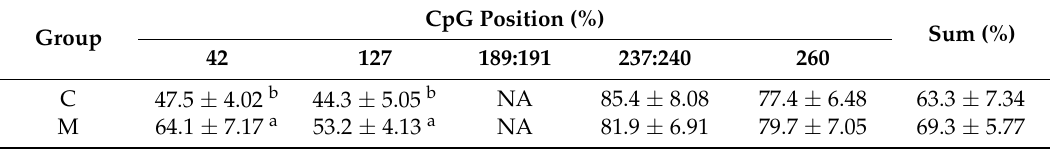
Table A3. Mean ± SEM effect of melatonin on methylation sequence of DNMT3a .